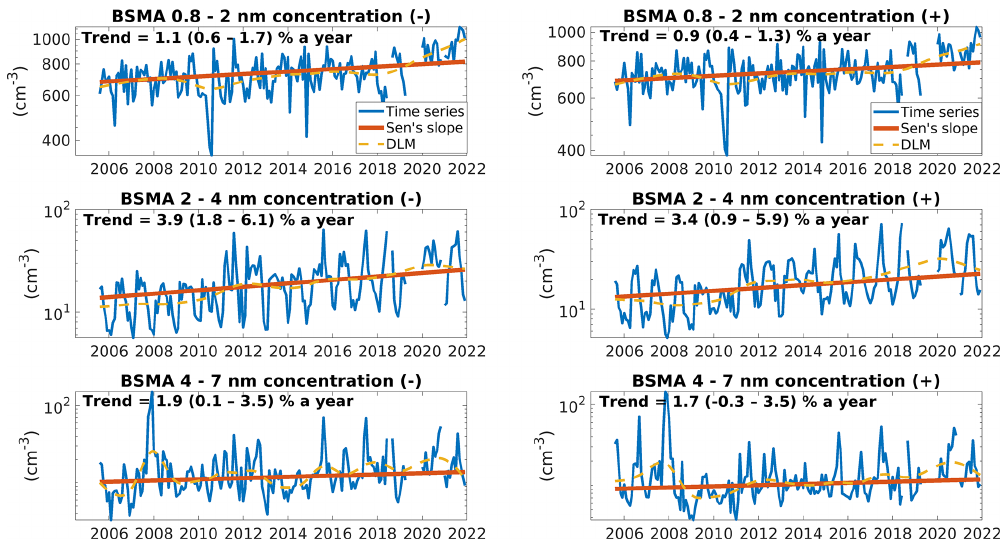
Figure 4. The time series of the cluster and intermediate ion concentrations. The relative changes per year have been calculated from Sen’s slopes. The values in brackets are the confidence intervals for the trend at a 90%